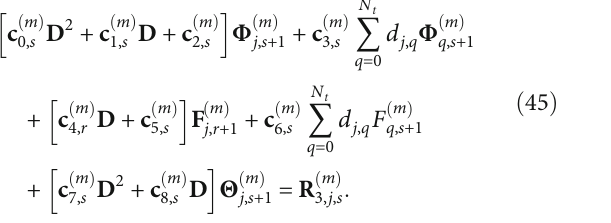
: 8, ξ = 1, N N Df = Sr = Bi = 0 : 5, He b = t = w = 0